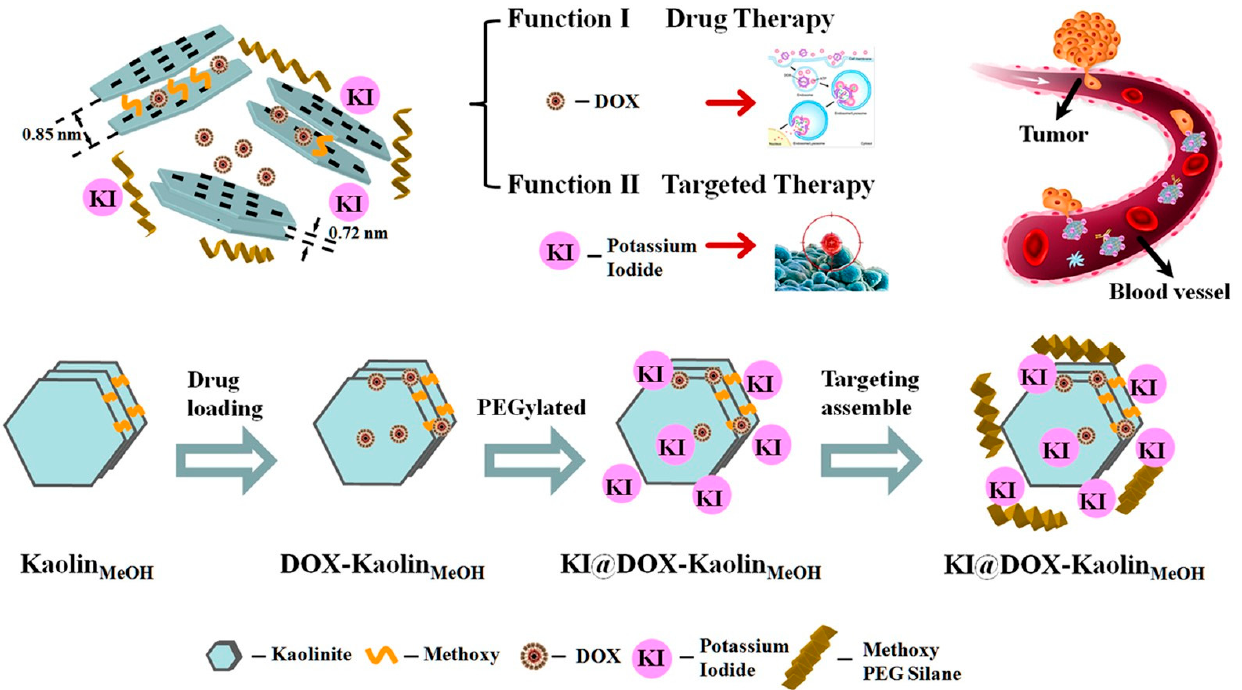
Figure 7. Schematic representation of the synthesis procedure of the methoxy-intercalated kaolinite nanocomposite functionalized with potassium iodide for thyroid cancer therapy. Reproduced from ref. [53].